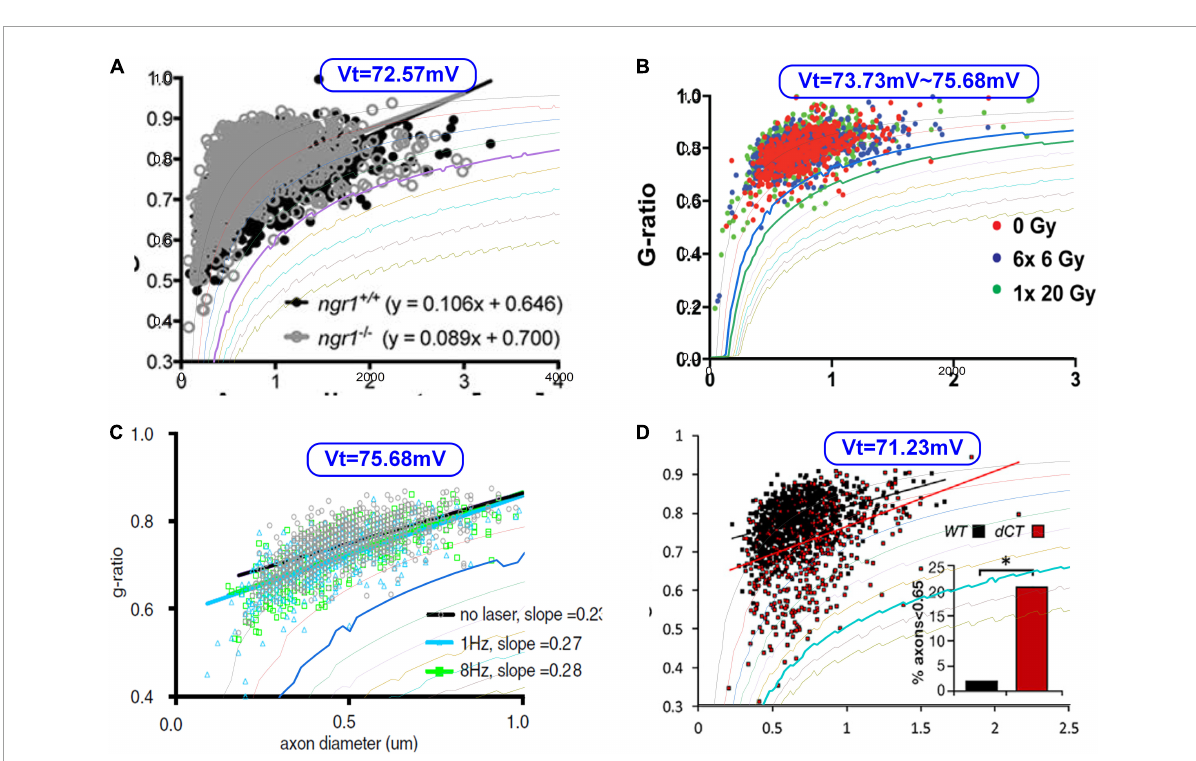
FIGURE13 The fitting of the lower limits of g-ratio data. (A) Lee et al. (2017); (B) Begolly et al. (2016); (C) Piscopo et al. (2018); (D) Elazar et al. (2019).